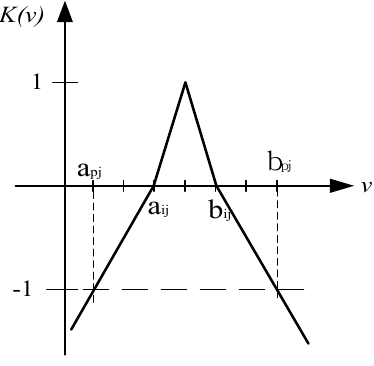
Figure 5. The proposed extension relation function.